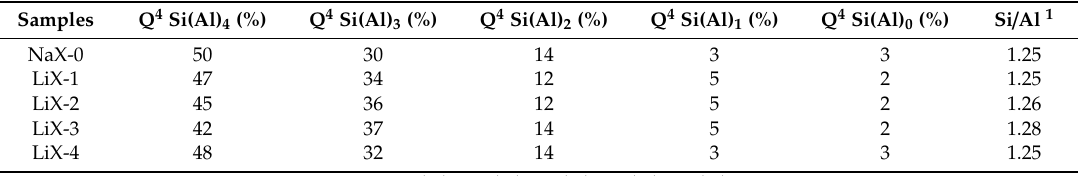
Table 4. Relative amount of Q 4 units (%) and Si / Al ratio determined from the 29 Si-MAS NMR spectra of the raw and lithium forms of FAU-type